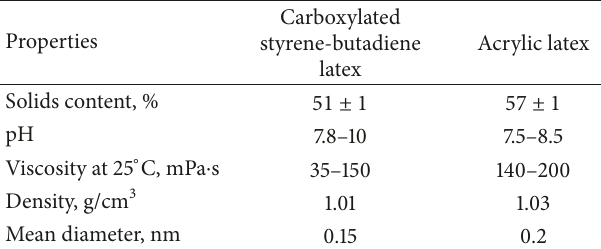
Table 2: Properties of